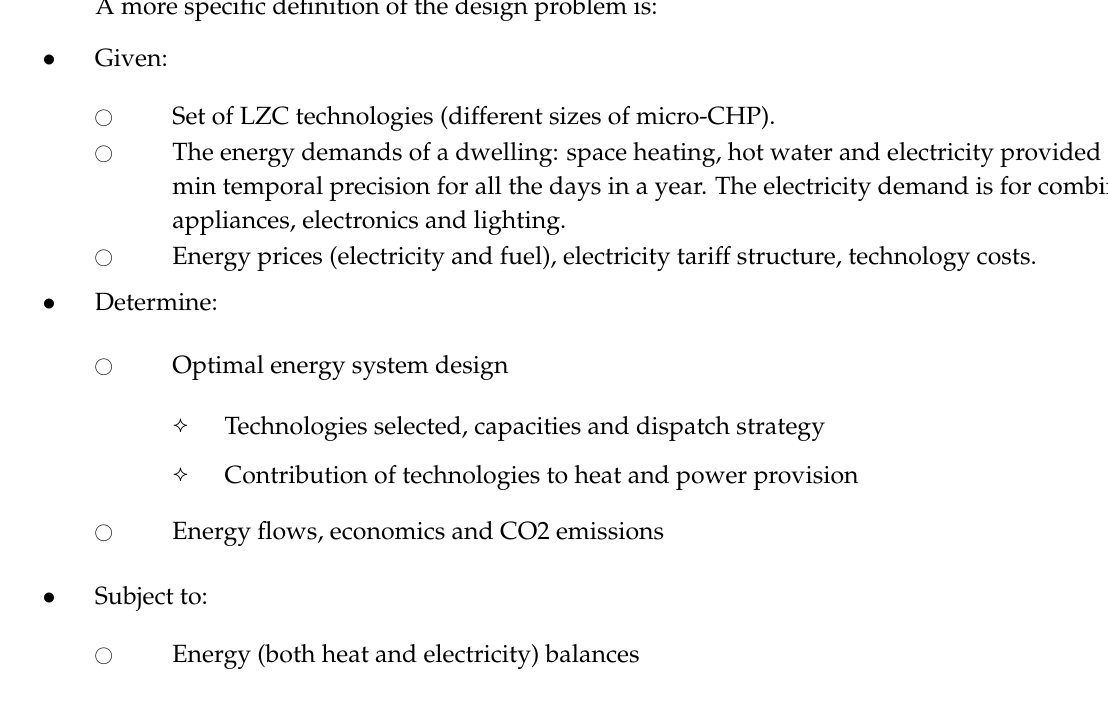
Figure 1. Model summary. CHP: Combined Heat and Power; TES: Thermal Energy Storage.